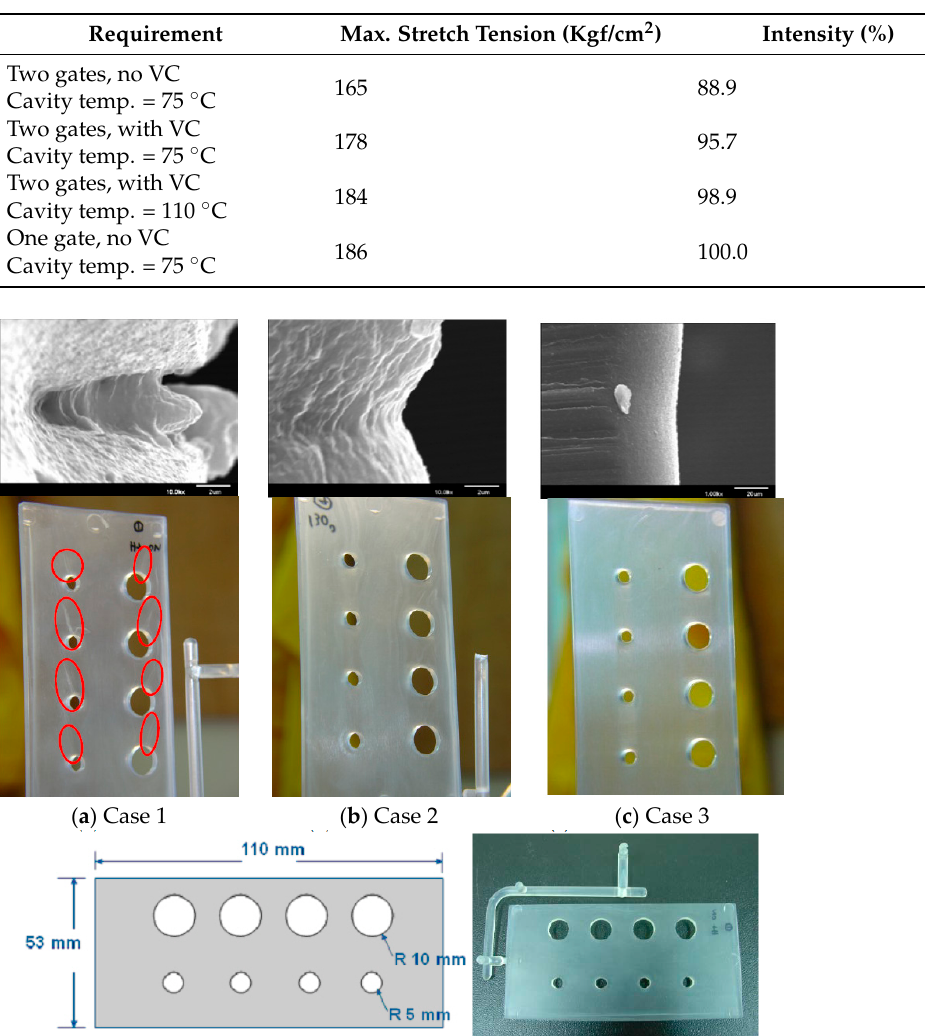
Table 1. The achievements of the tensile examination.